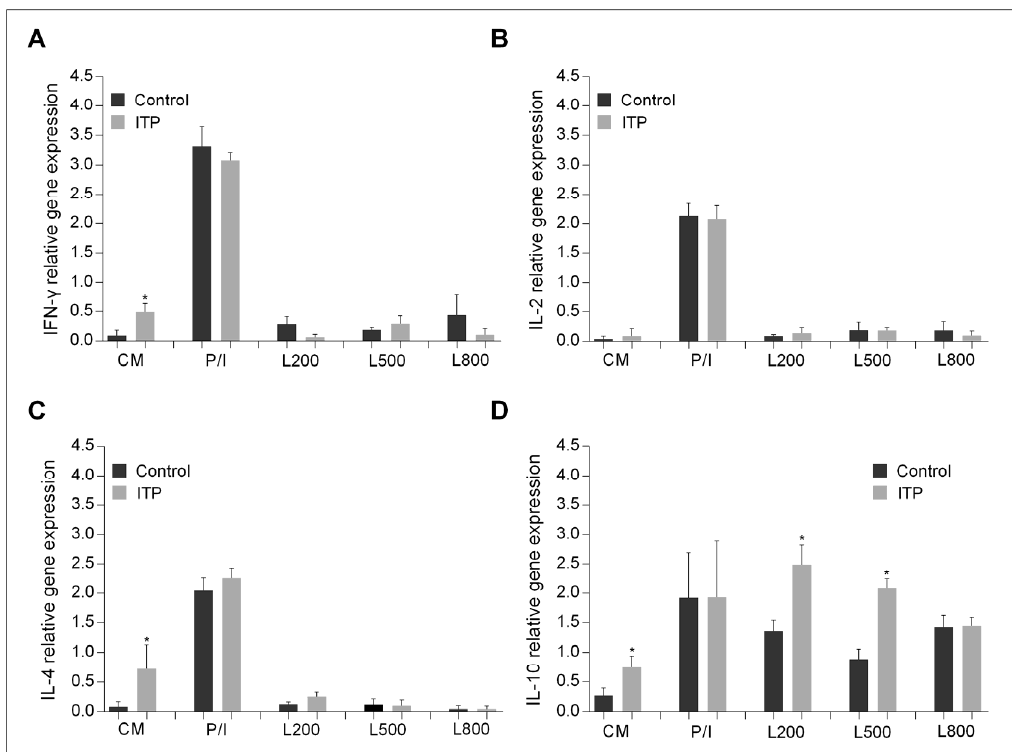
Figure 5. Effect of leptin on the expression of ( A ) IFN- γ , ( B ) IL-2, ( C ) IL-4 and ( D ) IL-10 in PBMCs isolated from controls and children with ITP in remission and cultured in plain culture medium (CM) or in the presence of phorbol myristate acetate and ionomycin (PI) or in the presence of recombinant human leptin at a concentration of 200 (L200) or 500 (L500) or 800 (L800) ng/mL. Cytokine gene expression is shown as mean (SD). Asterisks indicate statistically significant differences (* p < 0.05) compared to controls under the same culture conditions.